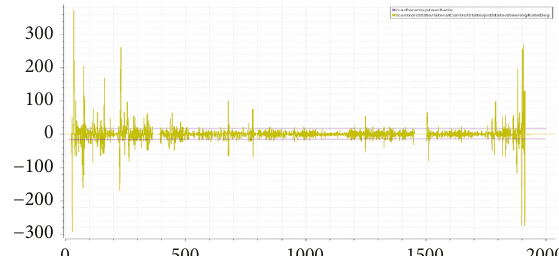
Figure 2: T1D1 left (1) and right (2) lane recognition.